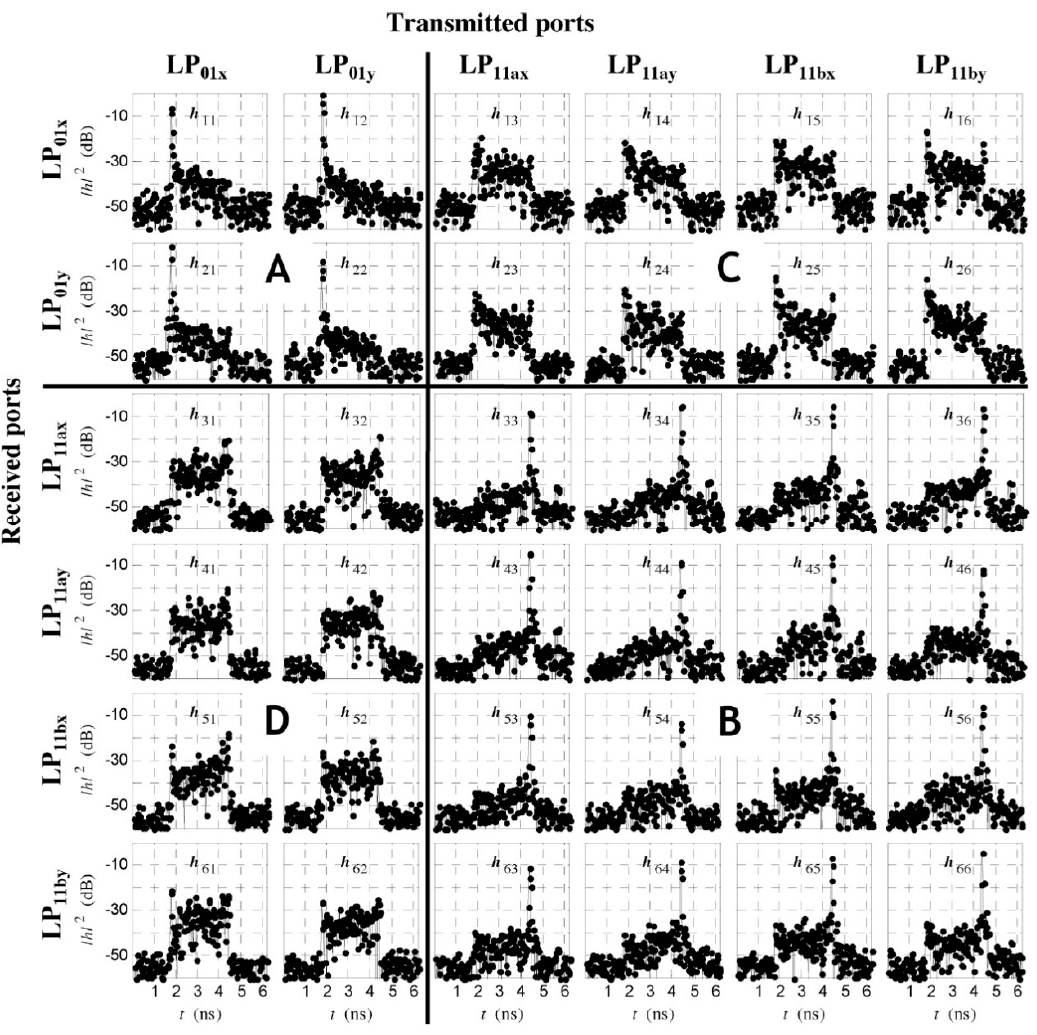
Figure 4. The squared magnitude of the 6 × 6 impulse responses for MIMO equalization [25].